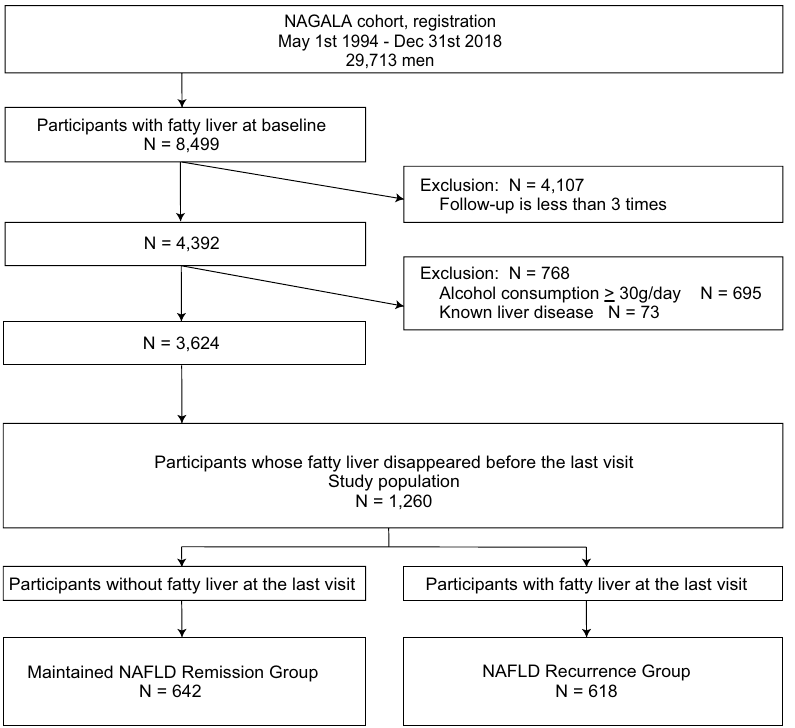
Figure 1. Flow diagram of study population selection in men. NAGALA, NAFLD in Gifu Area, Longitudinal Analysis; NAFLD, nonalcoholic fatty liver